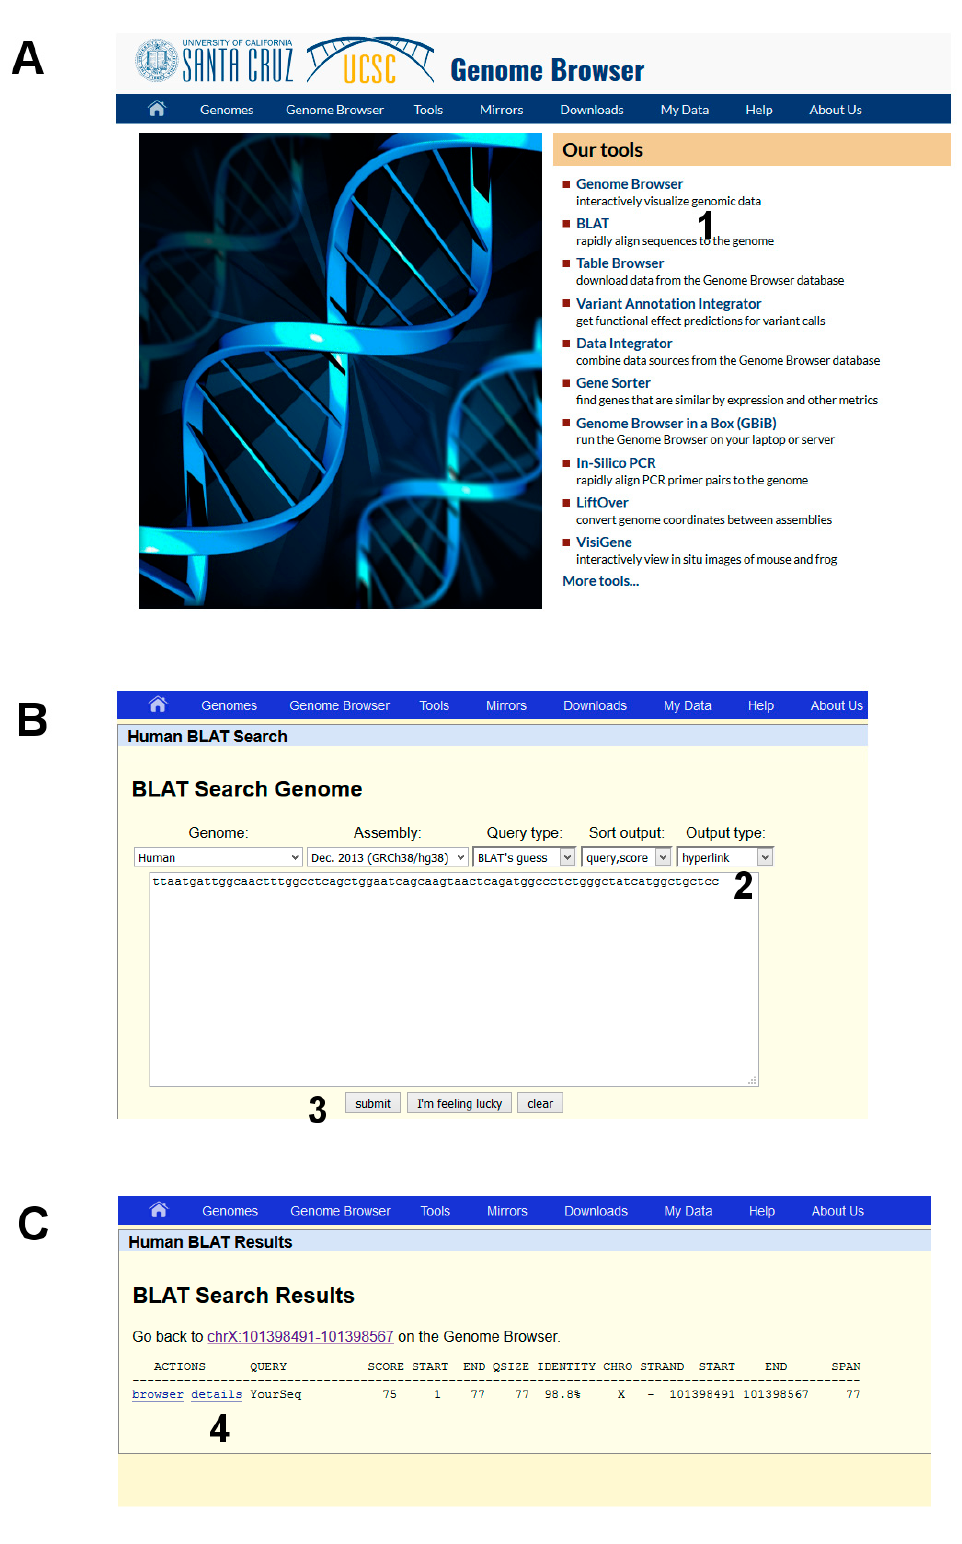
Figure 6. DNA analysis by using BLAT in the UCSC Genome Browser. ( A ) starting BLAT; ( B ) input data; and ( C) list of significant hits.